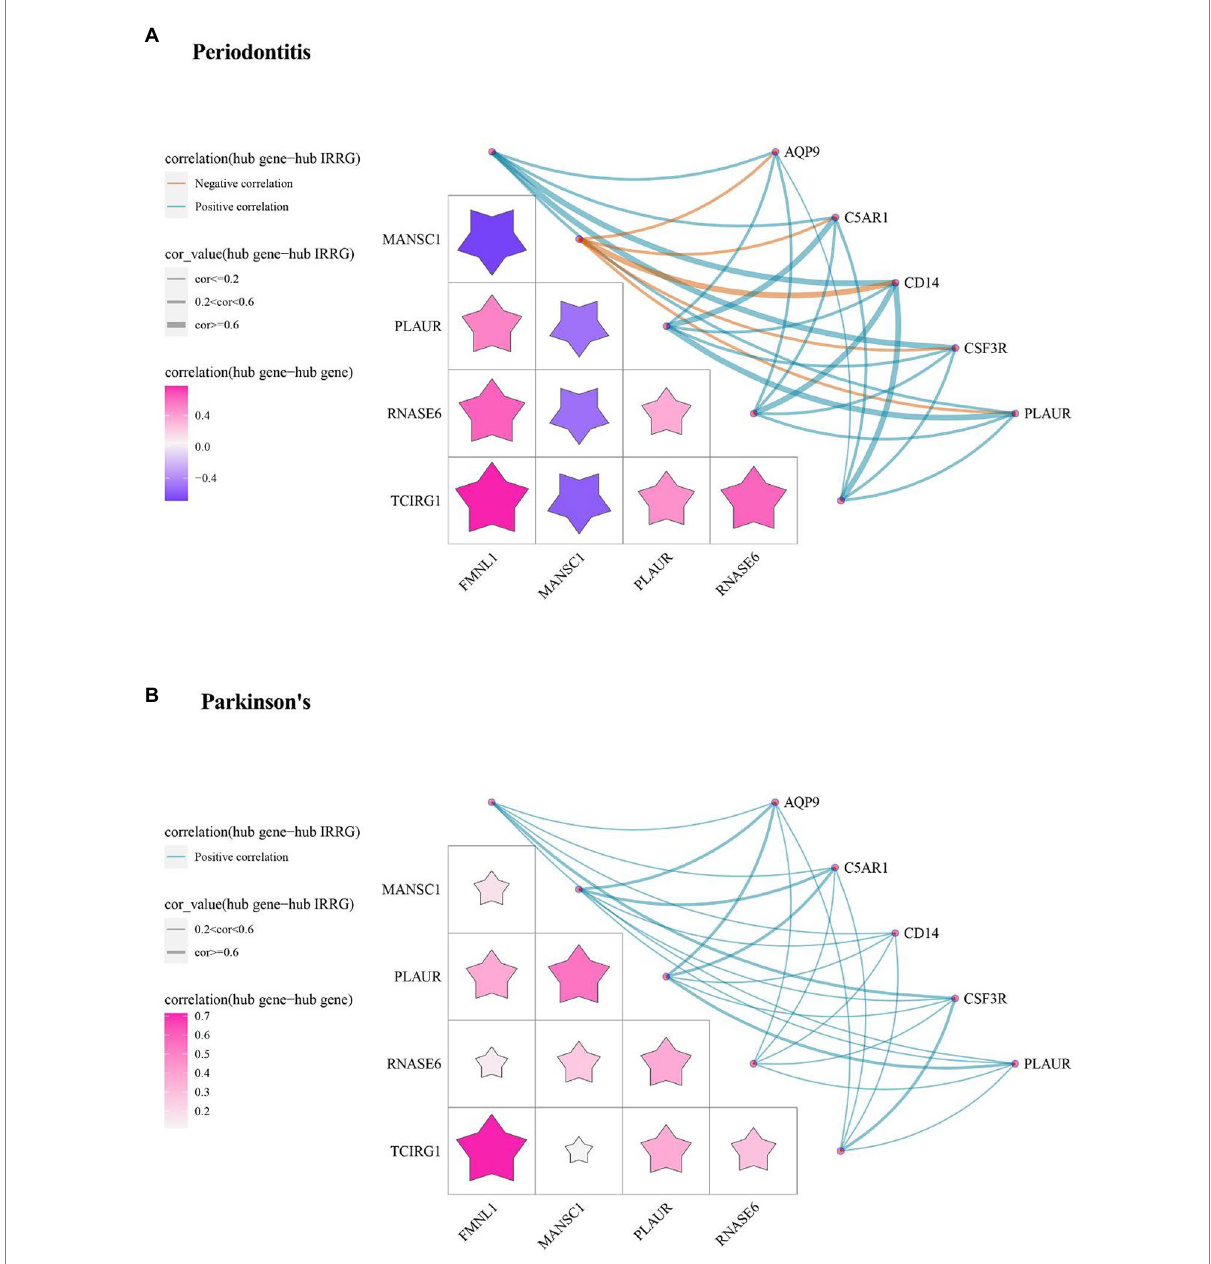
FIGURE 9 The relationships among Hub cross-talk genes and Hub IRRG in (A) Periodontitis disease and (B) Parkinson’s disease. The matrix graph in the lower left part of the figure shows the correlation coefficient between the hub cross-talk gene and the hub cross-talk gene, and the upper right part of the network diagram shows the correlation coefficient between the hub cross-talk gene and the hub